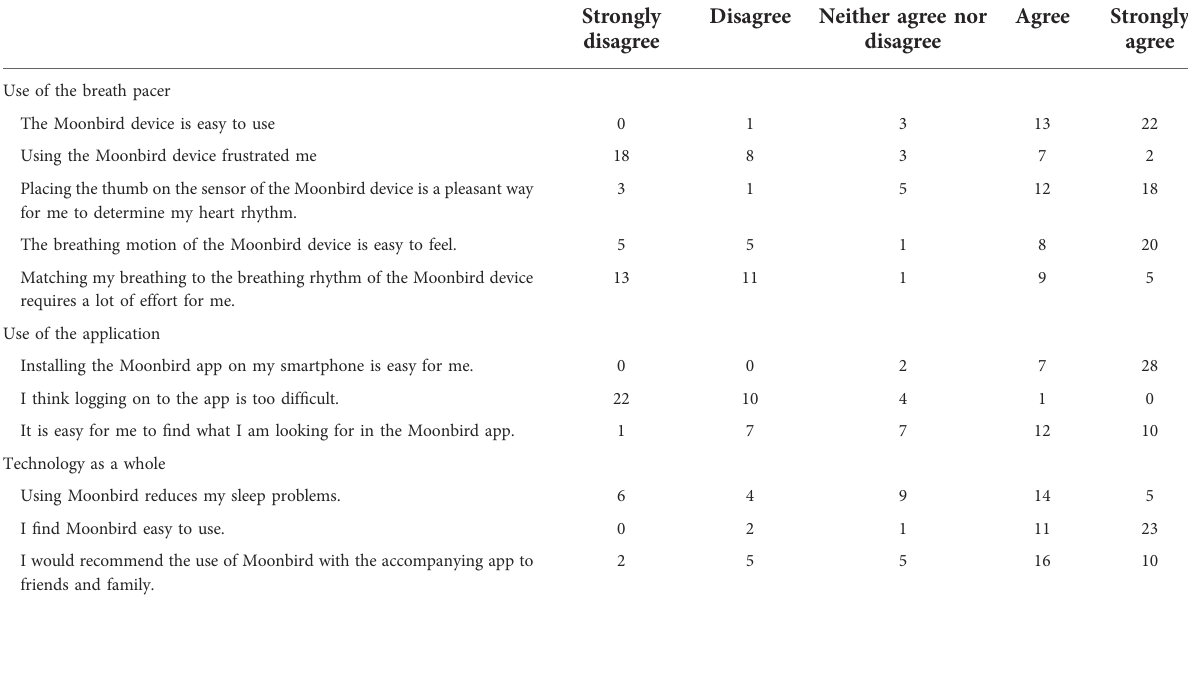
TABLE 2 Usability statements regarding the use of the breath pacer, application, and the technology as a whole.